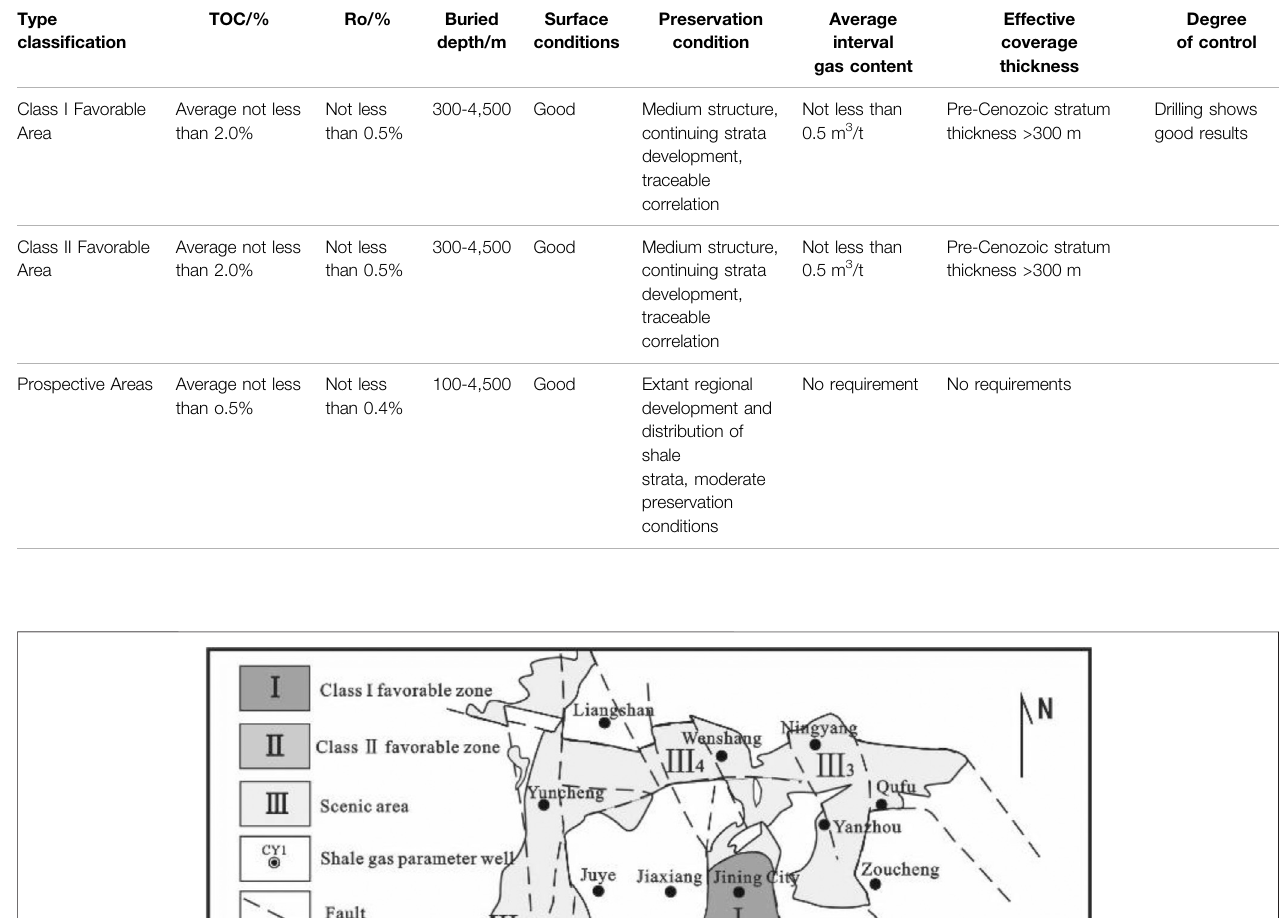
TABLE 4 | Reference standards for shale gas selection in the coal-bearing areas of Shandong Province.